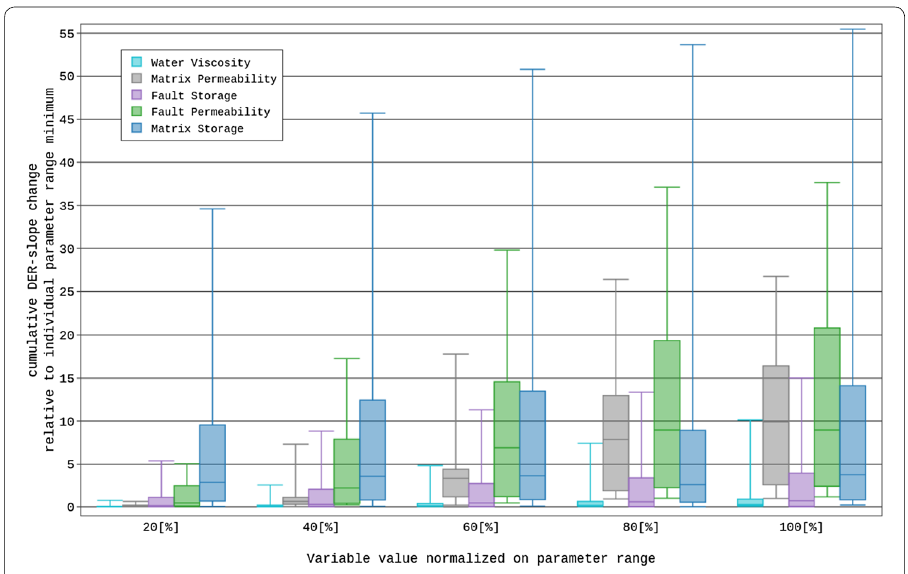
Fig. 9 Sensitivity plot; SC x (see Eq. 6) versus variable value change relative to individual parameter i ,min − x i , s , F j range